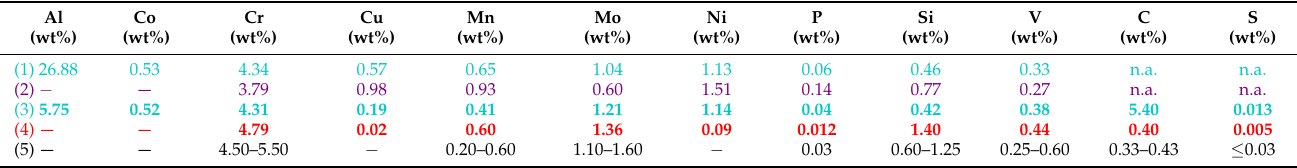
Table 5. Results of ICP OES and C-S-Analyzer for filter cakes of SE_01 + SE_02 without oil (1 +